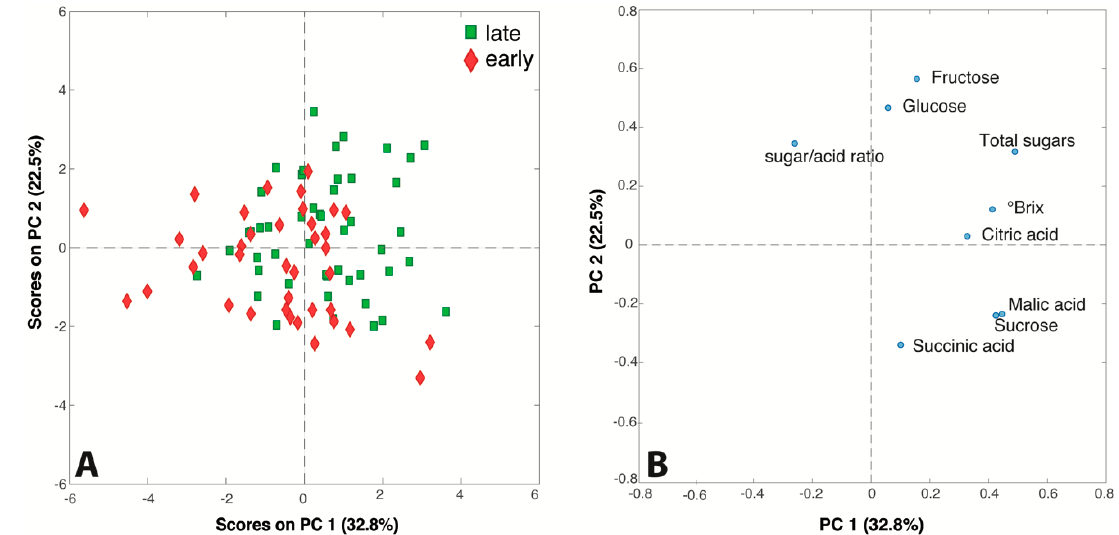
Figure 2. (A) Score and (B) loading plots of the PCA model performed on the ion chromatography and °Brix Figure 2. ( A ) Score and ( B ) loading plots of the PCA model performed on the ion chromatography and ◦ Brix dataset .